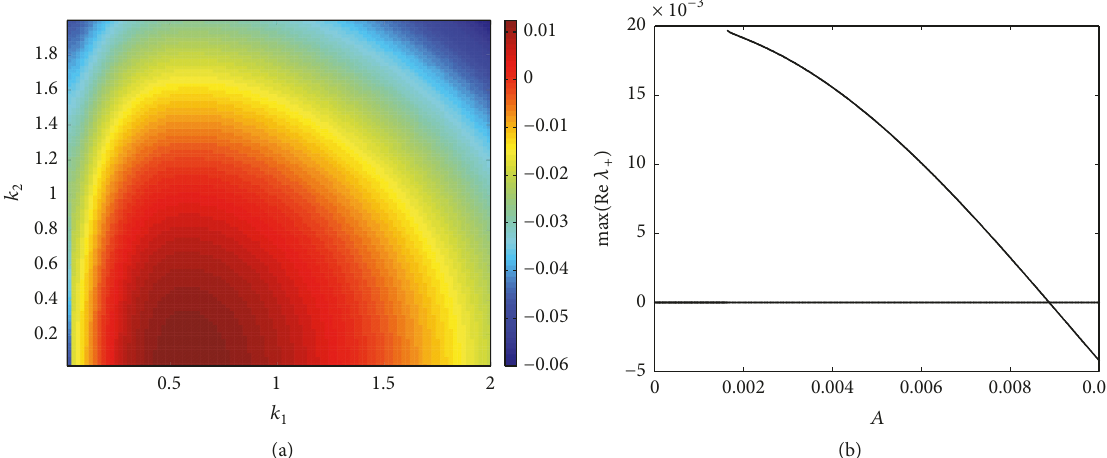
Figure 2: (a) Graph of Re (𝜆 + (𝑘 1 ,𝑘 2 )) when 𝐴 = 0.005 and (b) change of max ( Re (𝜆 + (𝑘 1 , 𝑘 2 ))) with the variation of parameter 𝐴 . 𝑈 = 10.